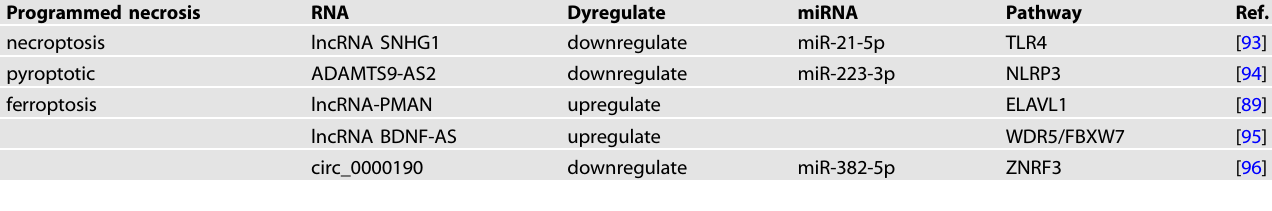
Table 1. Non-coding RNAs that regulate programmed necrosis in gastric cancer cell. Programmed necrosis